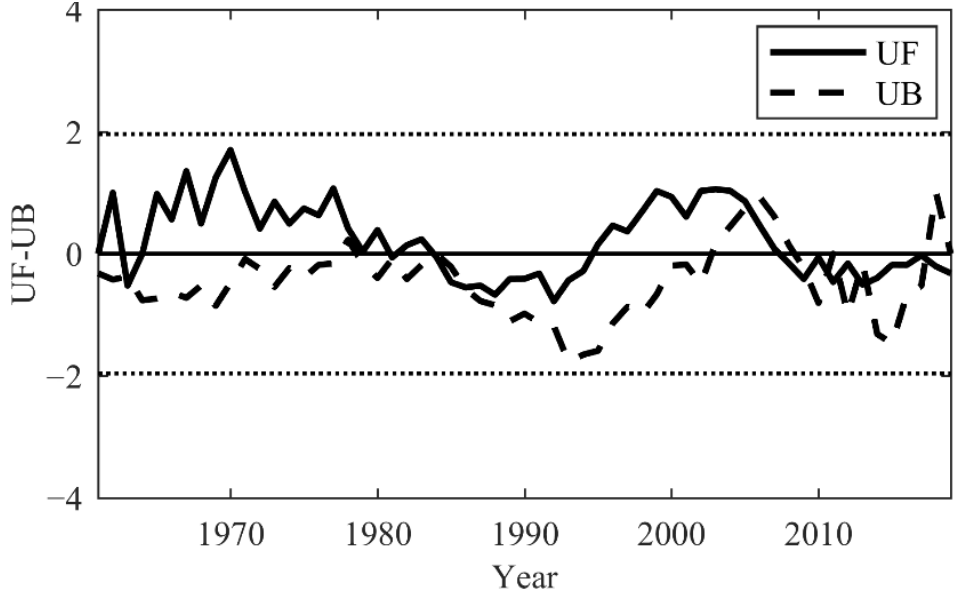
Figure 2. Mutation test result. For the given time series, the Mann–Kendall (MK) test defines the values of test statistic UF as a standardized variable with zero mean and unit standard deviation, and the values of UB are computed backward. The intersection points of the UF and UB curves indicate the possible turning year in the time series at the corresponding threshold level (i.e., ±1.96 for 95% significance level).